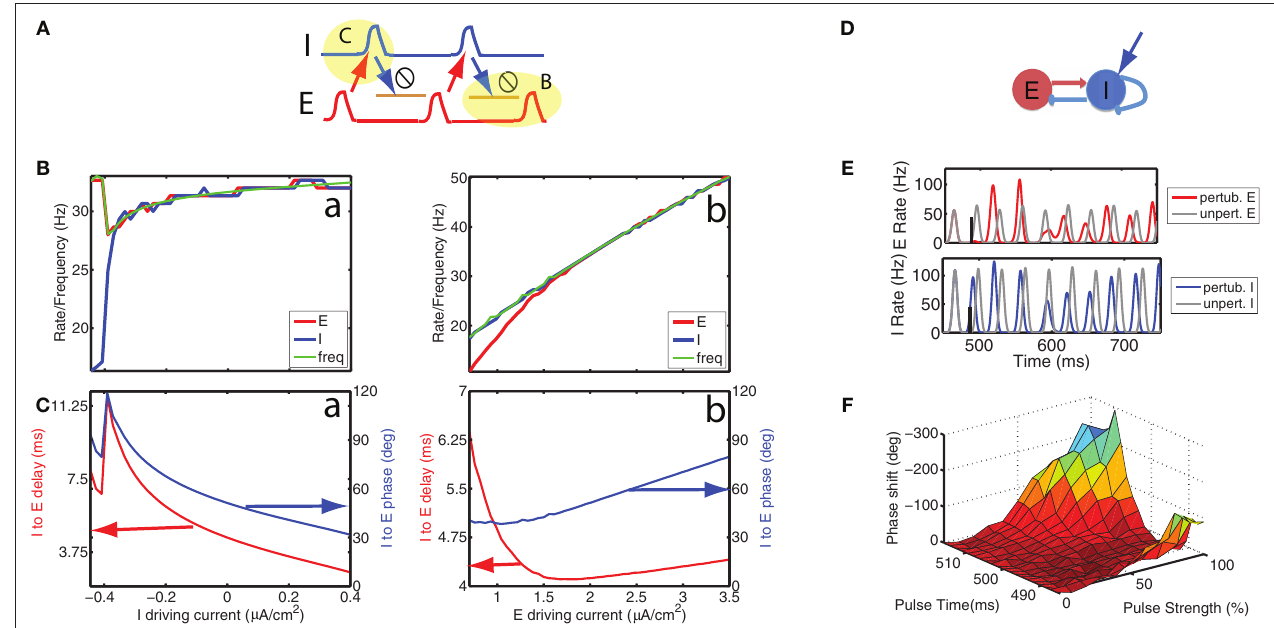
consider a network with reciprocal connections between E and I cells as well as mutual inhibition between I cells, which are also stimulated optically. ( e , top) E-cell spike time histogram for (gray) the unperturbed network and (red) the network perturbed by a pulse to the I cells. ( e , bottom) I-cell spike